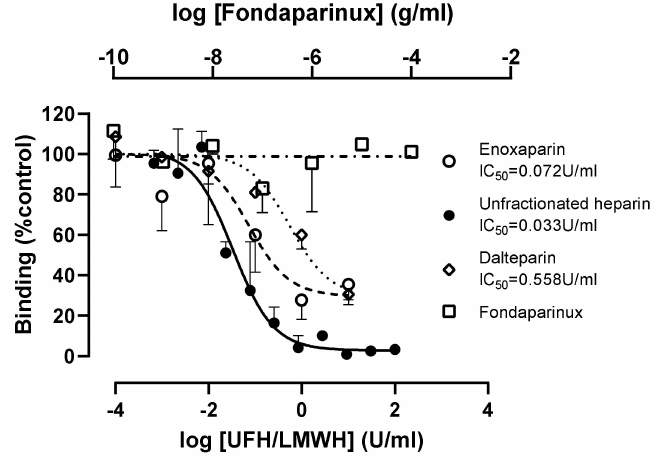
Figure 7. Concentration-dependent inhibition of S1S2 interaction by unfractionated heparin and low-molecular-weight heparins, dalteparin and enoxaparin but not synthetic pentasaccharide, fon- daparinux. RT4 cells were pre-incubated with the stated concentrations of unfractionated heparin, enoxaparin, dalteparin and fondaparinux for 30 min at 37 ◦ C, then with 100 nM wtS1S2 for a further 60 min at 37 ◦ C before fluorescent secondary anti-His6 was added for a further 30 min at 21 ◦ C. Cell-associated fluorescence was measured by flow cytometry and is shown as a percentage of the wtS1S2 attachment to untreated control cells. Data are the means ± SEM of 2–3 experiments performed in duplicate.